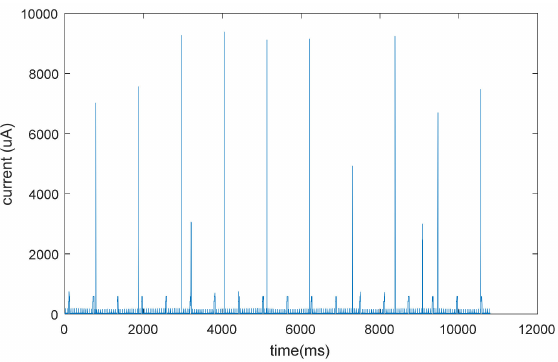
Figure 2. Node current consumption as a function of time, in the presence of vibration-triggered